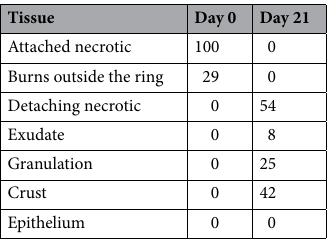
Table 3. The percentage of disbudding wounds in which the tissue was present in calves (n = 12, each with 2 horn buds) disbudded 0 (n = 24 wounds) or 21 days (n = 24 wounds)